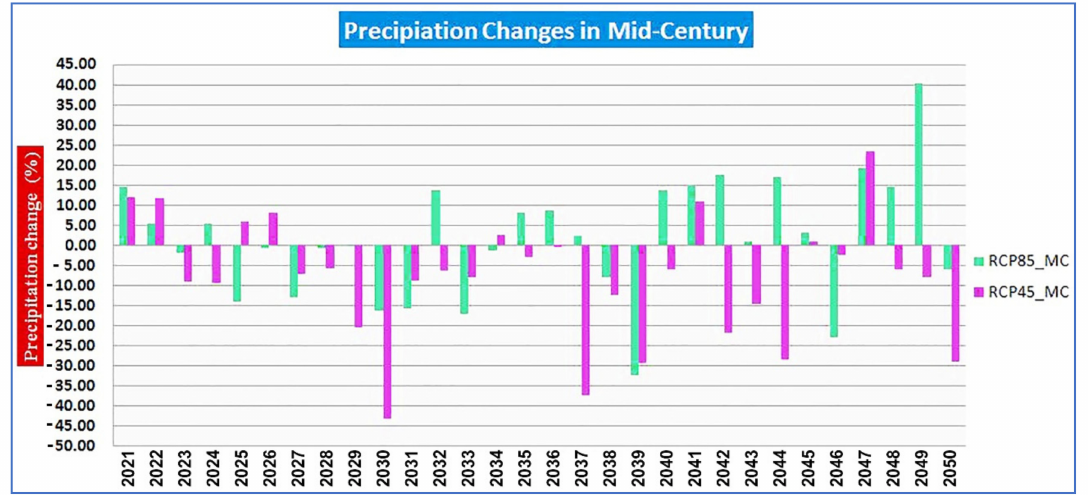
Figure 8. The projected precipitation change in percentage from MC to EC, concerning historical precipitation for the multimodel ensemble of RCM (RCP